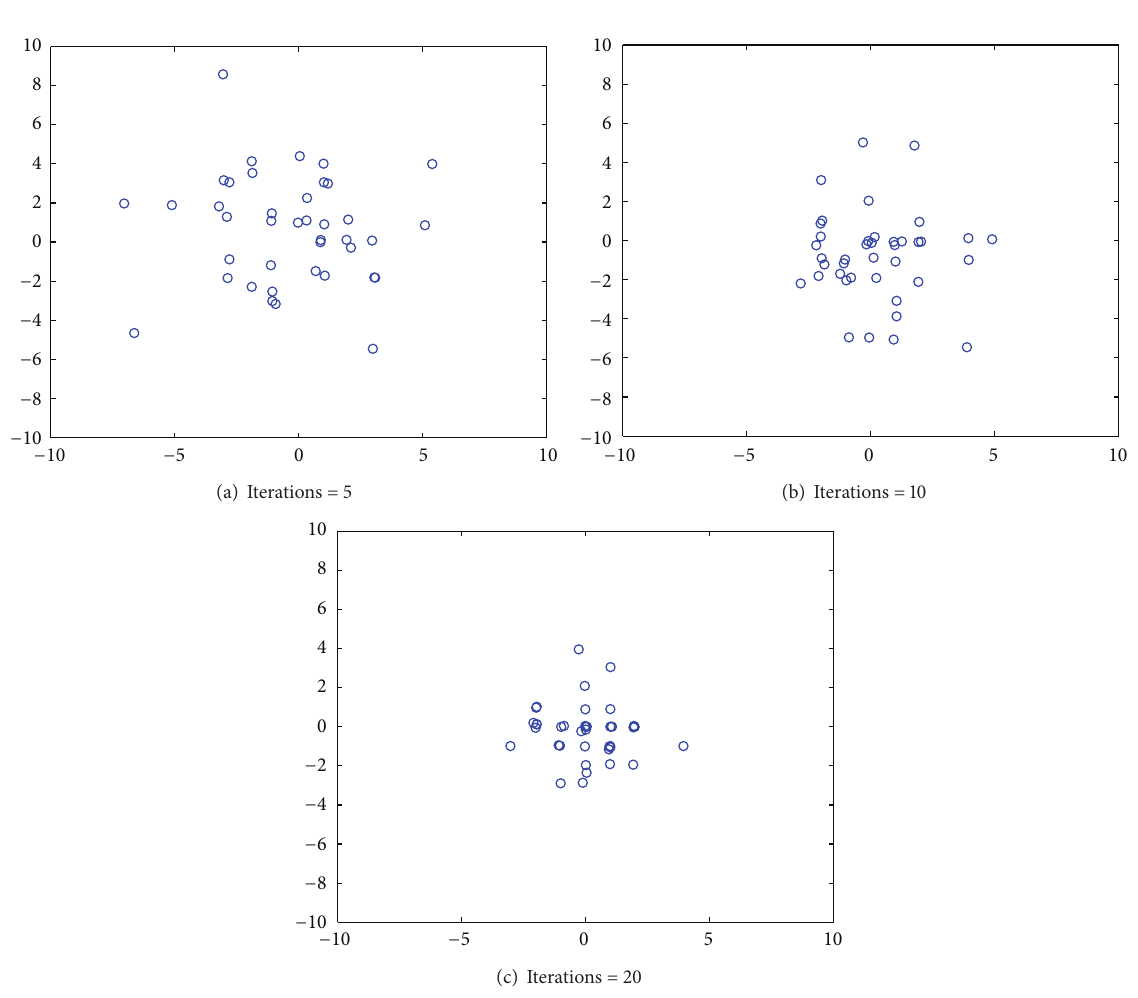
Figure 1: Population distribution observed at various stages in